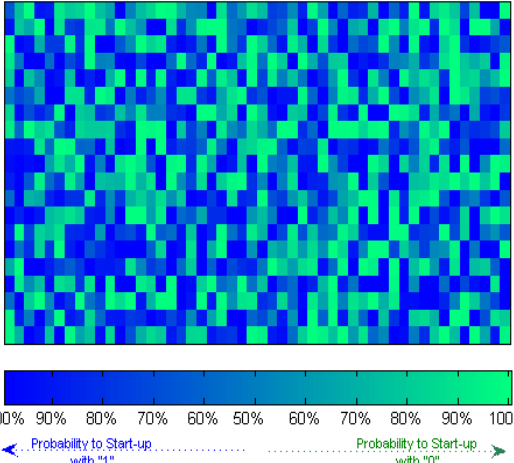
Figure 10. Visualization of the probability of each memory cell to start up to a preferred SUV.